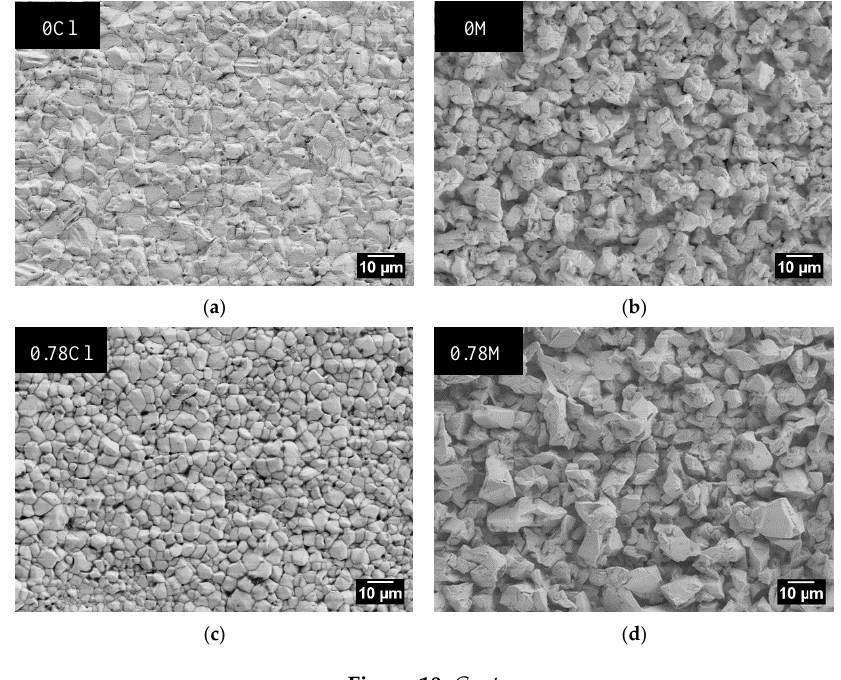
1.56Cl Figure 10.